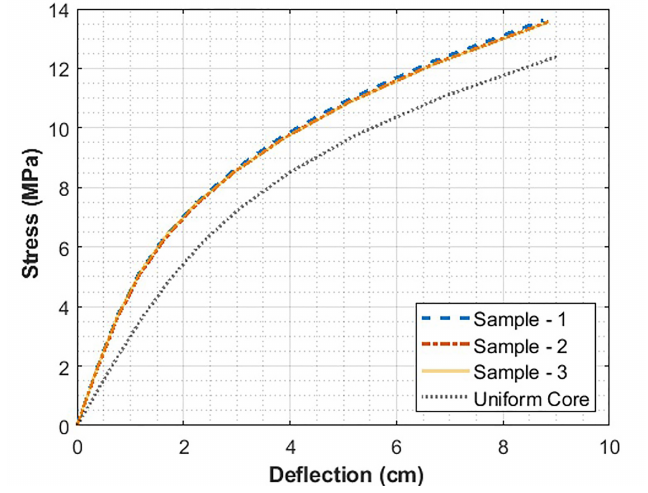
Figure 12. Stress comparison for the various FEA models with image cross-sections and the uniform